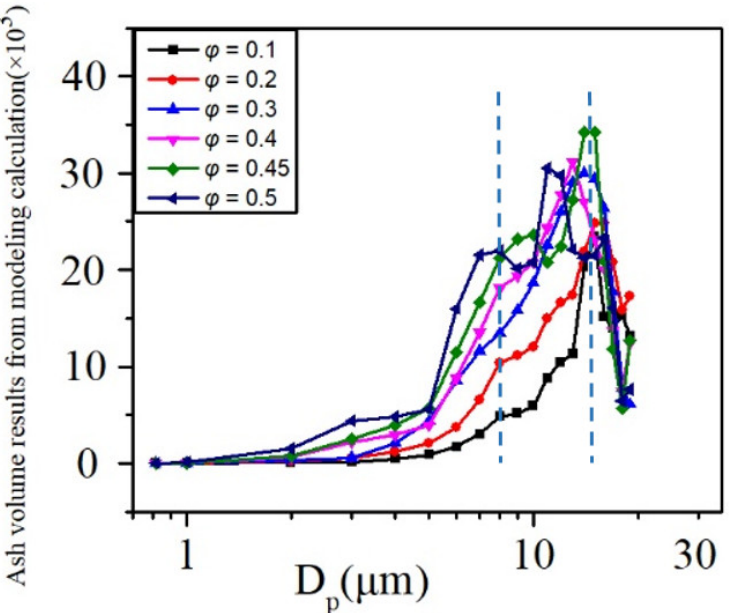
Figure 10. Particle number size distribution.